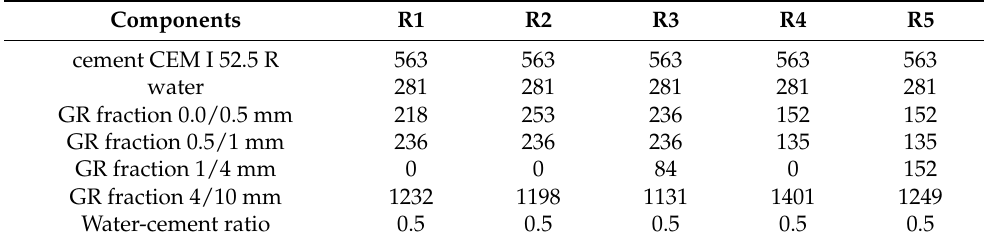
Table 4. Recipe composition (dose in kg).